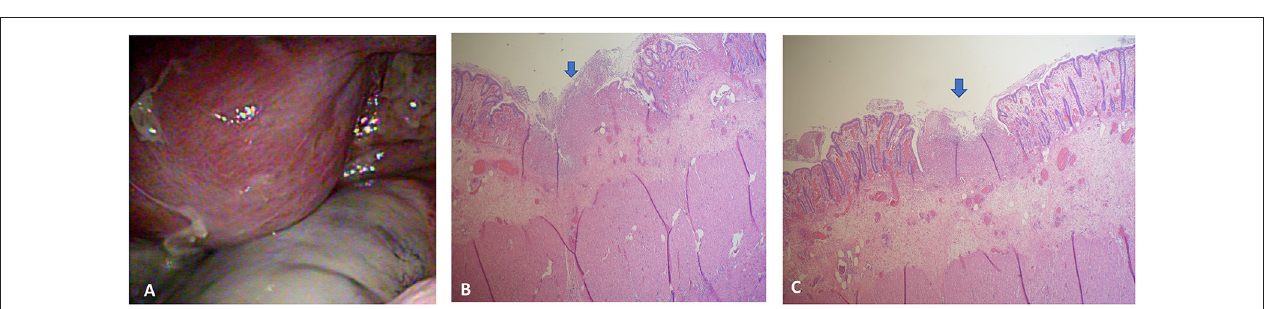
FIGURE 2 | Abdominal CT revealed much fecal impaction and colon dilatation along with colon wall thickening and pneumatosis intestinalis (arrow).